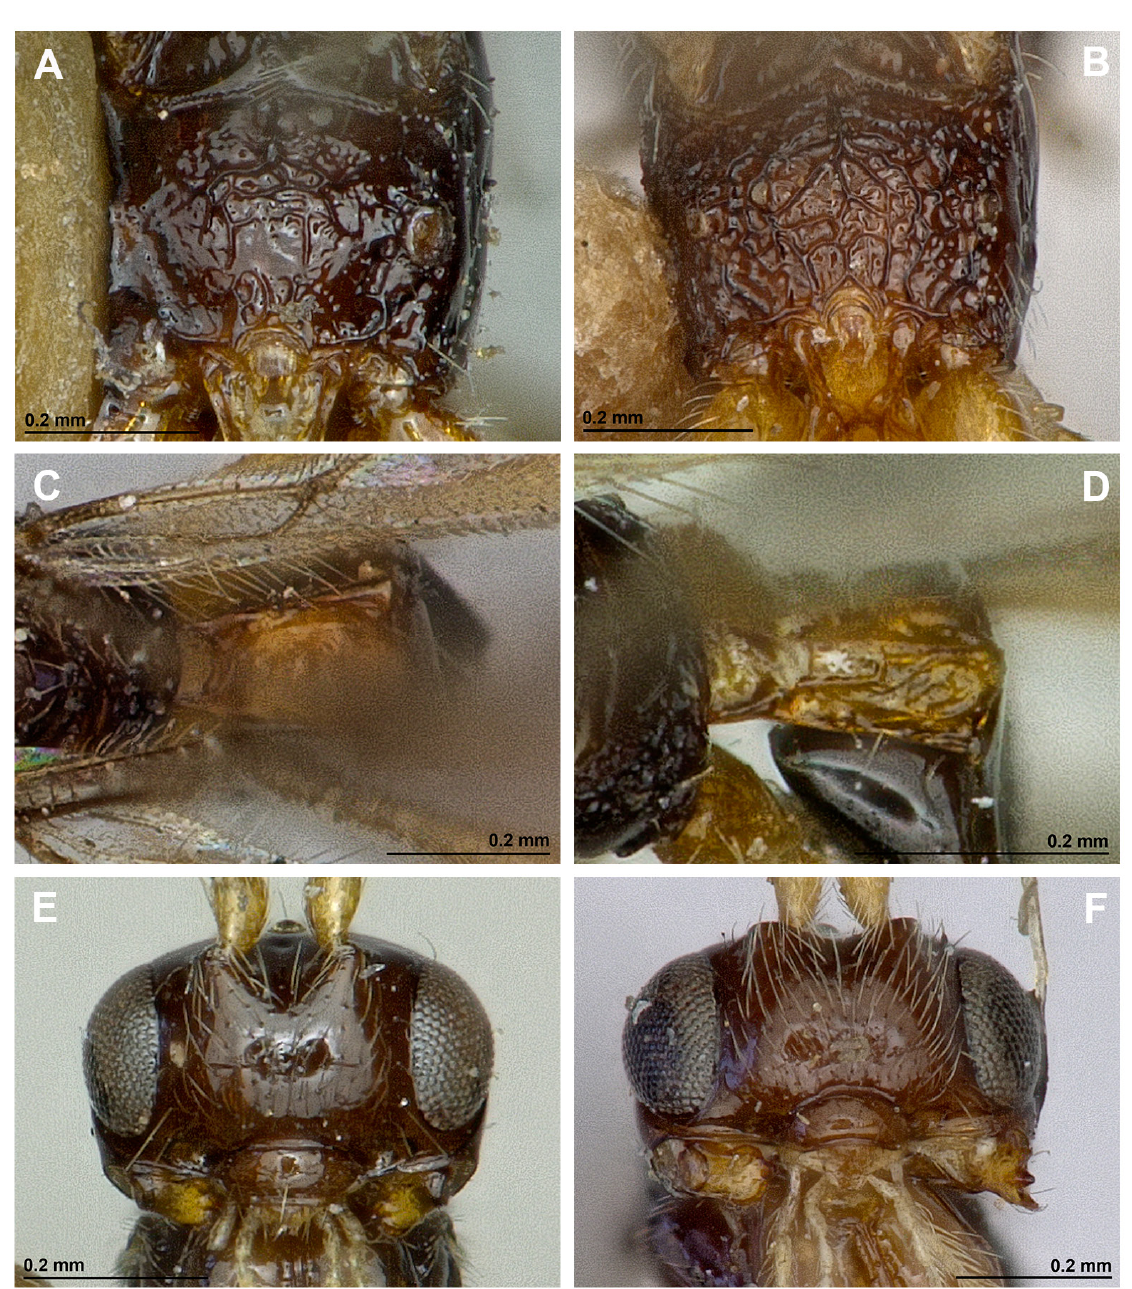
Fig. 14. A . Propodeum of Synaldis spiraculosa Fischer, 1967, dorsal view. B . Mesonotum of S. sensillosa Fischer, 1967, dorsal view. C . First metasomal tergite of S. megaseliae Fischer, 1967, dorsal view. D . First metasomal tergite of S. liliputana Fischer, 1967, dorsal view. E . Head of S. liliputana Fischer, 1967, front view. F . Head of S. altera Fischer, 1967, front